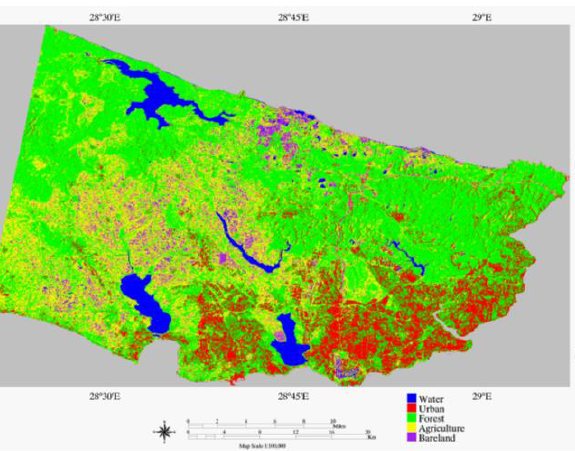
Figure 4. Classification result of VV,VH, (VV-VH) image. Using more than one variable significantly increased the classification accuracy. Especially scenarios 7 and 8 has higher accuracies than other scenarios with 93.2755% and 93.1550%